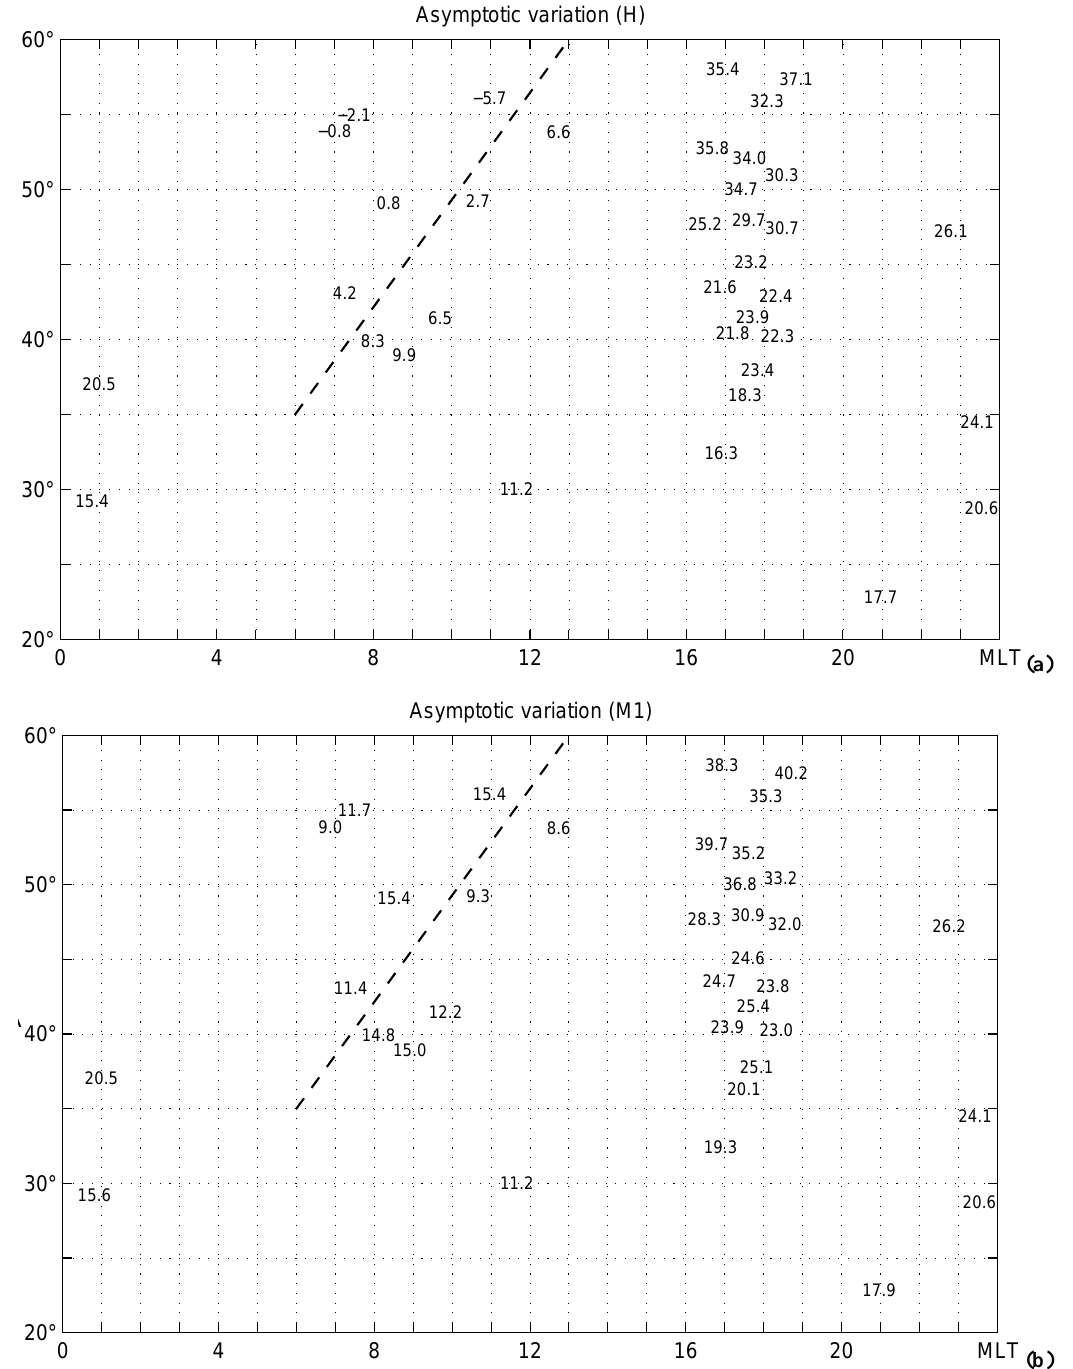
Fig. 9. The asymptotic variation (in nT) at different ground stations. Top plot: H component; bottom plot: the variation along the M1 axis.